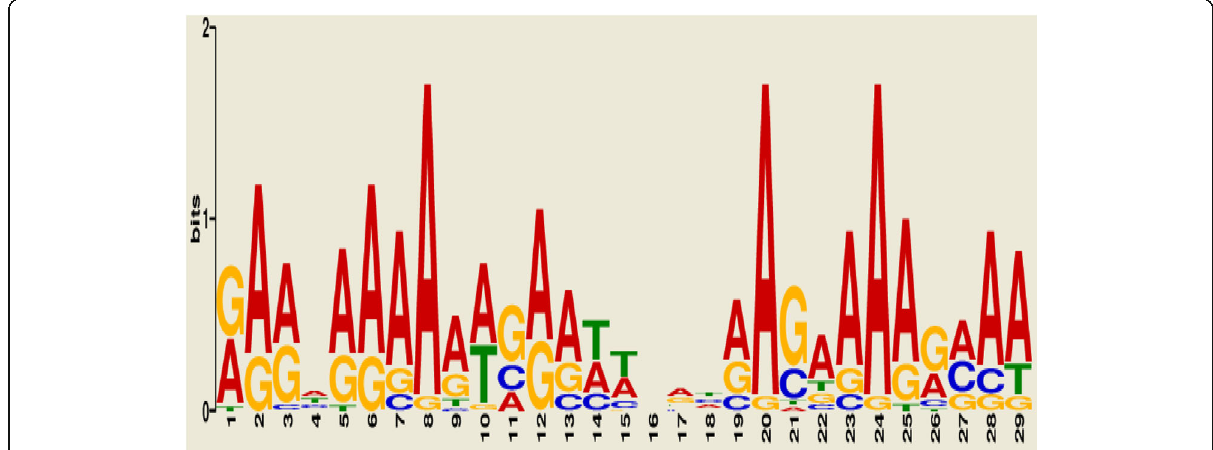
Fig. 2 Sequence logo for the identified common promoter motif M Sp 1 for gene encoding alcohol production gene in S.